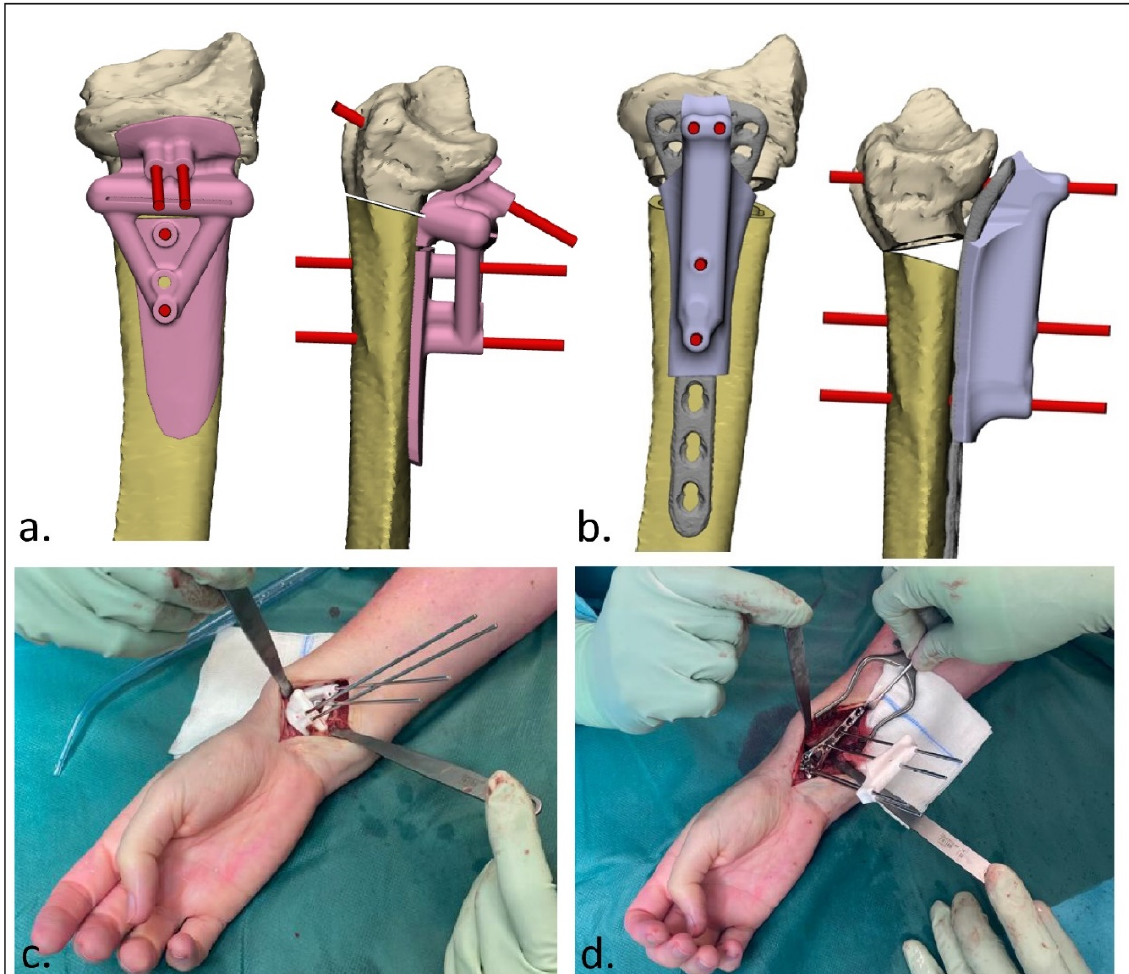
Figure 2. 3D-guided patient-specific corrective osteotomy of a malunited distal radius that was initially treated conservatively in a cast (Case 6). ( a ) Frontal and lateral view of the designed cutting guide (pink) with the -wires (red); ( b ) frontal and lateral view of the designed reposition guide (purple) with the parallel K-wires (red); ( c ) operative usage of the cutting guide; ( d ) operative usage of the reposition guide. The specific design of the reposition guide allowed for at least two screws to be drilled and placed both distal and proximal to the osteotomy level. Note the convergent K-wires in the cutting guide ( c ), and the parallel K-wires as reduction aids in the reposition guide ( d